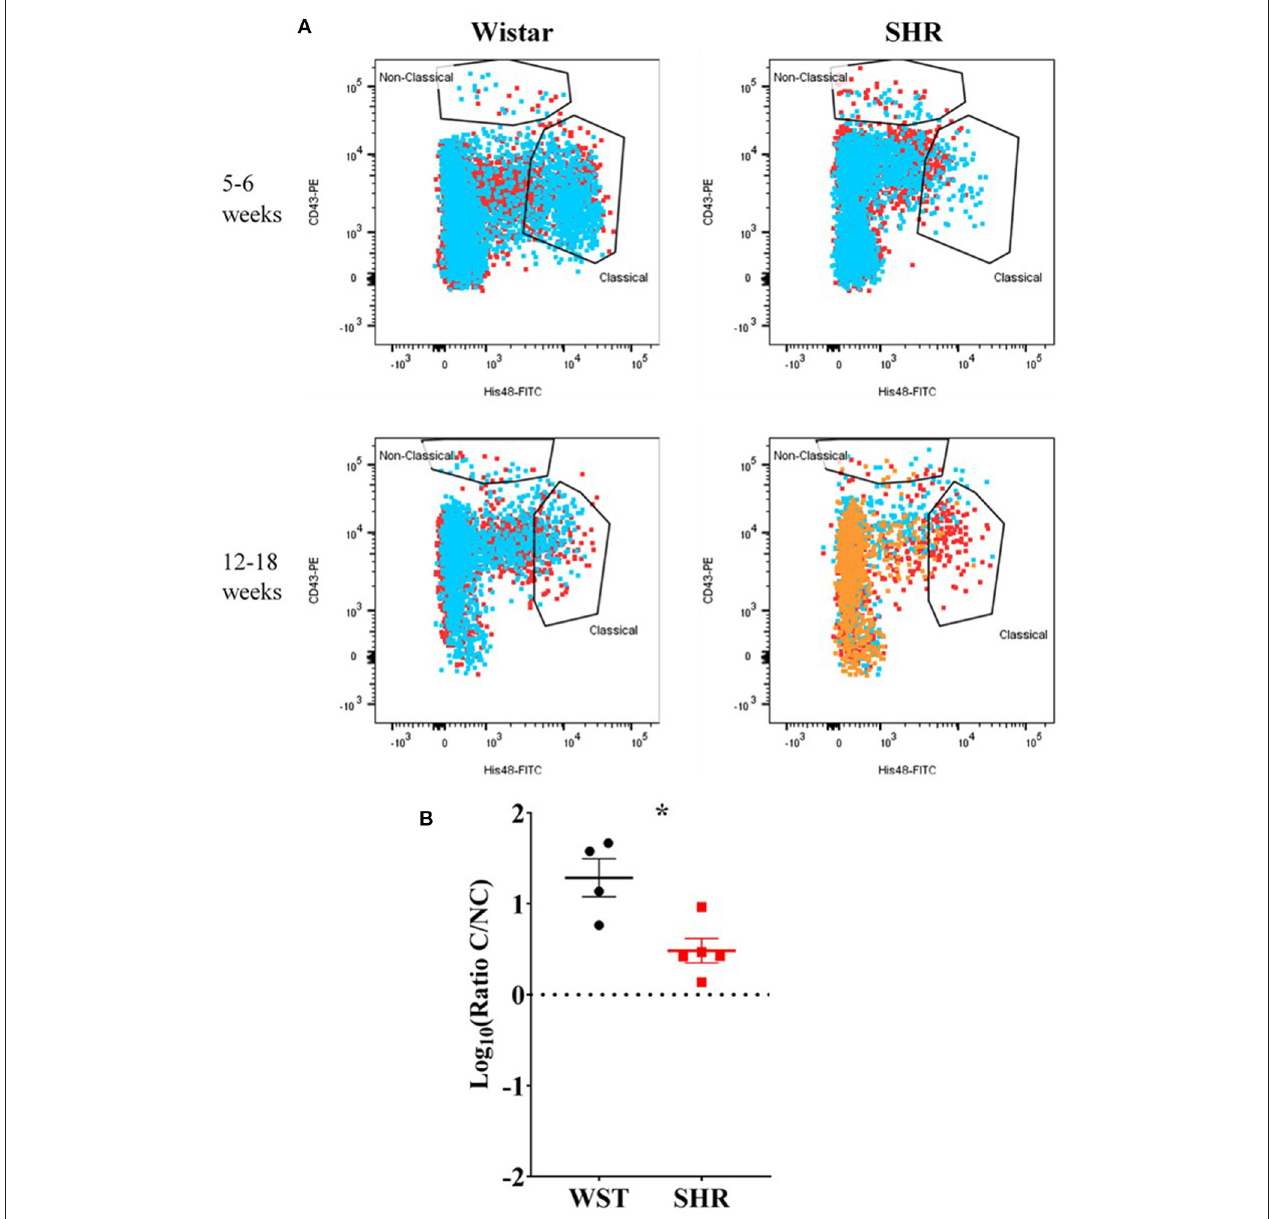
FIGURE 4 | Monocyte-macrophages from the stellate ganglia of SHR n = 5 samples, 3 rats per sample, and age-matched Wistars ( n = 4 samples, 3 rats per sample) at 5–6 weeks (developing hypertension) and 12–18 weeks (established hypertension). (A) Flow cytometry plots of all samples; each color represents a separate sample of ganglia from 2–3 rats. (B) Classical/non-classical monocyte-macrophage ratio from all 5-18 week old animals; Data are expressed as mean ± SEM. *signifies p < 0.05 WST vs. SHR, Welch’s t-test.